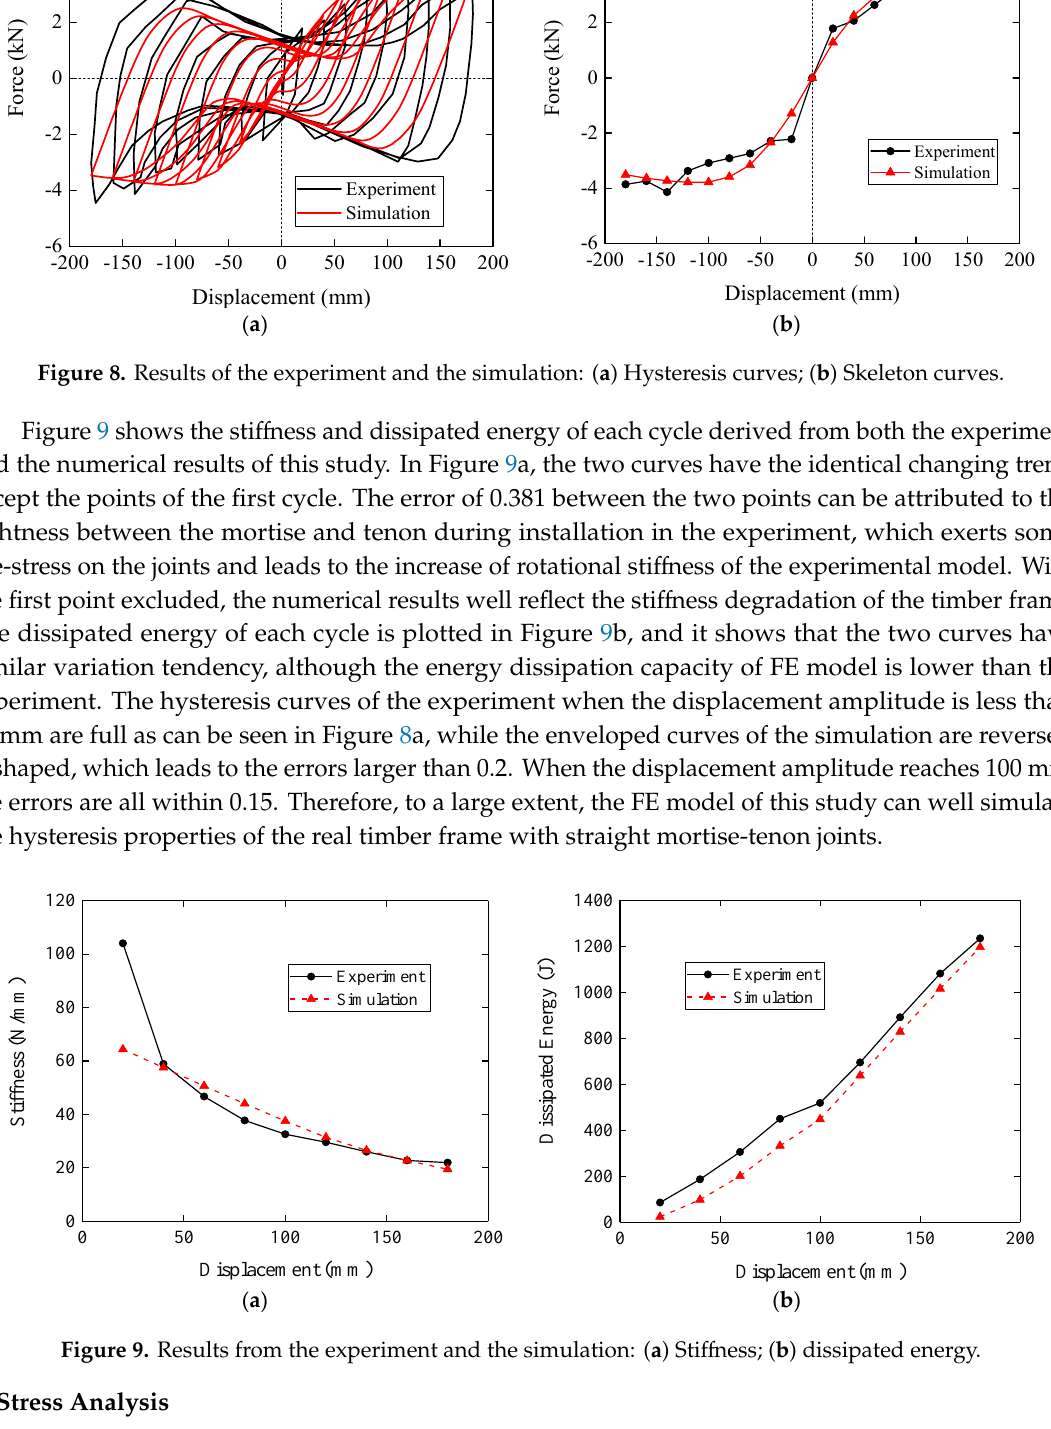
12mm Figure 7. Hysteresis curves of models with different element sizes. The experimental hysteresis curves from Lin [22] and from the model with element size of 20 mm are plotted in Figure 8 for clearly comparison. It can be seen from Figure 8a that the hysteresis curve of this study is reversed Z-shaped and well reflect the pinch effect of the timber frame. However, the unloading stiffness is about 35% smaller than the experimental results, which is also